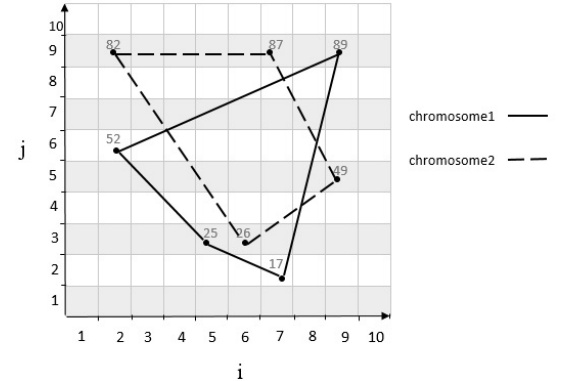
Figure 10. Scope of parent